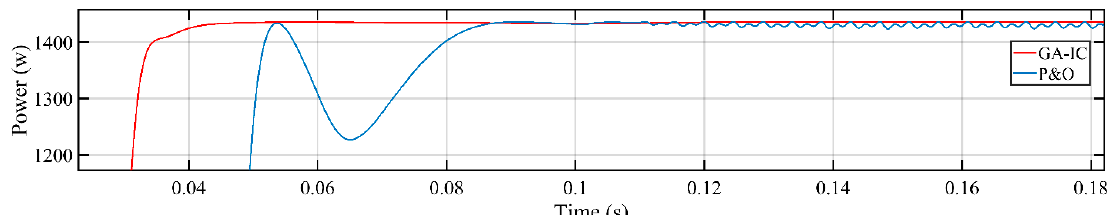
Figure 32. Case 3 power comparison of modified GA-IC vs. P&O.